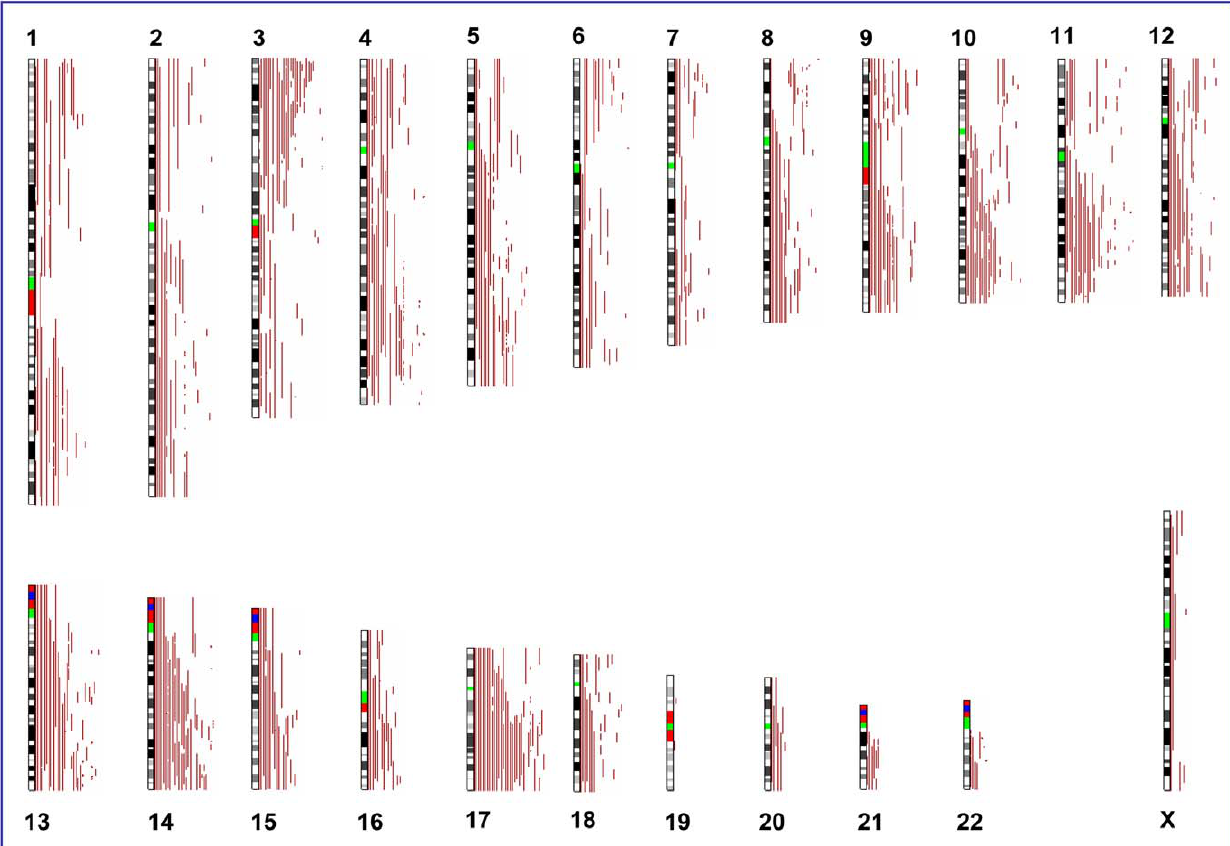
( Table 3 ) in TN breast cancer samples. Segmental aUPD occurs with mitotic recombination error, which leads to homozygous region and usually no copy number changes, however, in some cases one of these two alleles loss and remaining allele can be amplified